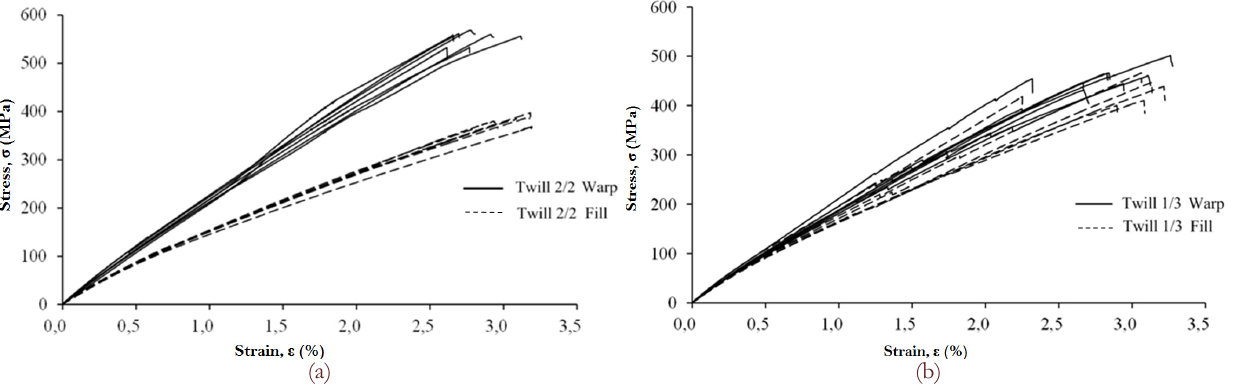
Figure 8: Stress-strain diagrams as results of the experimental tensile tests: (a) fabric type twill 2/2 in warp and fill direction; (b) Fabric type twill 1/3 in warp and fill direction.